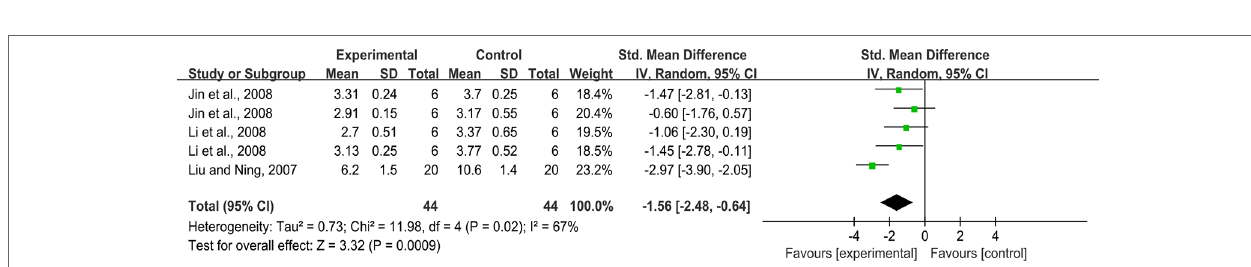
FiGURe 5 | Pooled estimate of kidney tubules injury index with rhein.